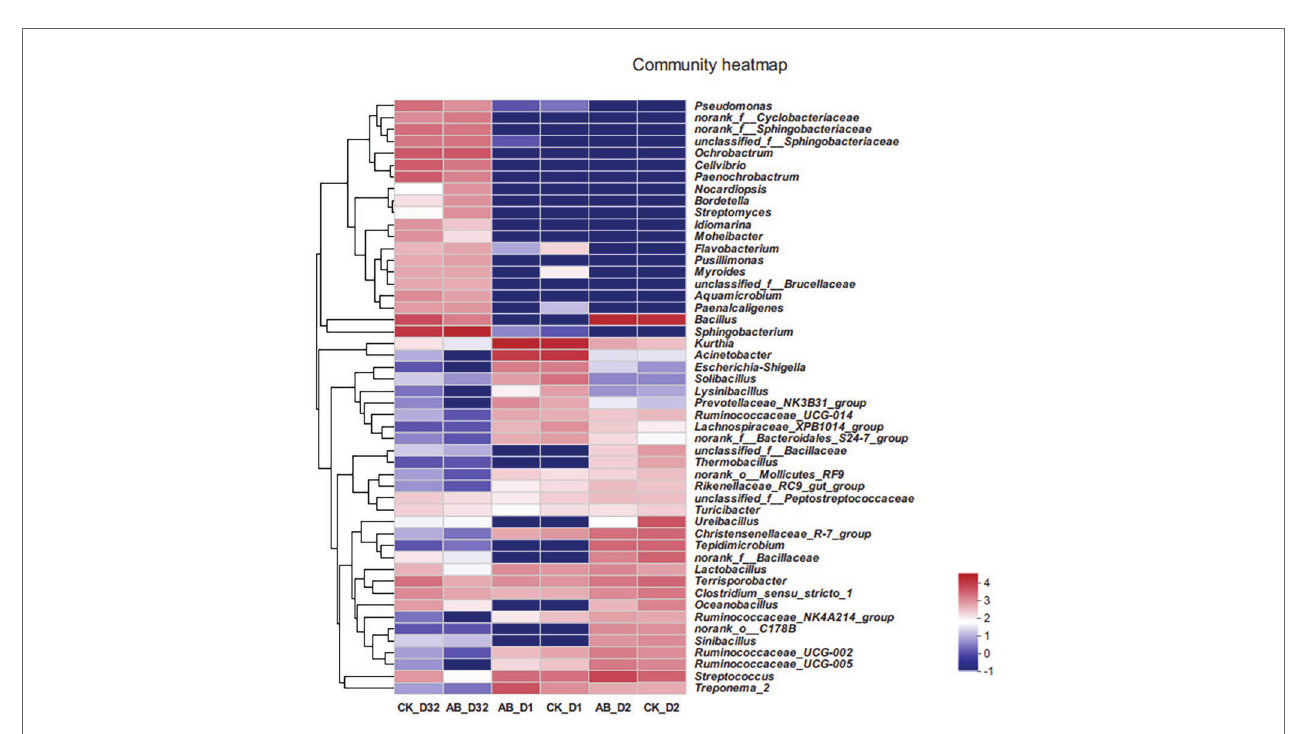
FIGURE 5 | Heat map of species abundance at the genus level in compost. CK: the swine manure composting. AB: add 1% compound microbial agents in the swine manure composting. D1 represents the mesophilic phase, D2 represents the thermophilic phase, and D32 represents the maturation